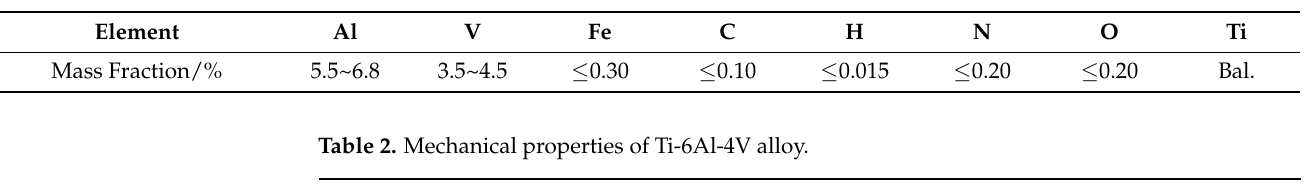
Table 1. Main chemical composition of Ti-6Al-4V alloy.